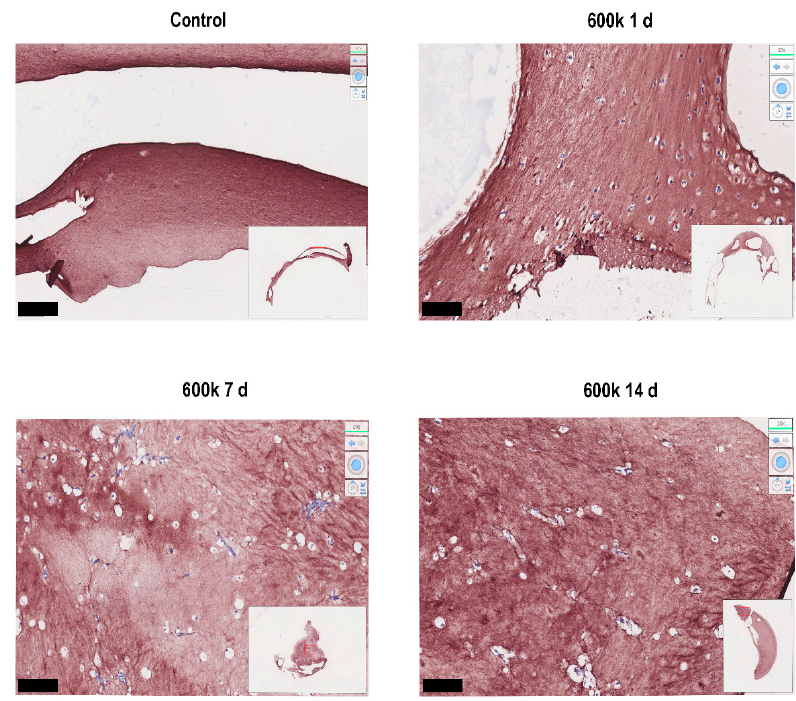
Figure 8. Immunohistochemical staining for the presence of collagen type I. LV ECM hydrogels were seeded with 600 k HPMEC and assessed at days 1, 7, and 14 for collagen type I. Bare hydrogels served as controls. Micrographs shown are areas with representative VNF taken from scans by Hamamatsu imaging at 20 × magnification (insets). Collagen fibers are visible as a fibrous meshwork, while cells are white with a blue nucleus. Scale bars represent 100 µm.